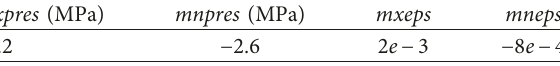
Table 3: MAT_ADD_EROSION